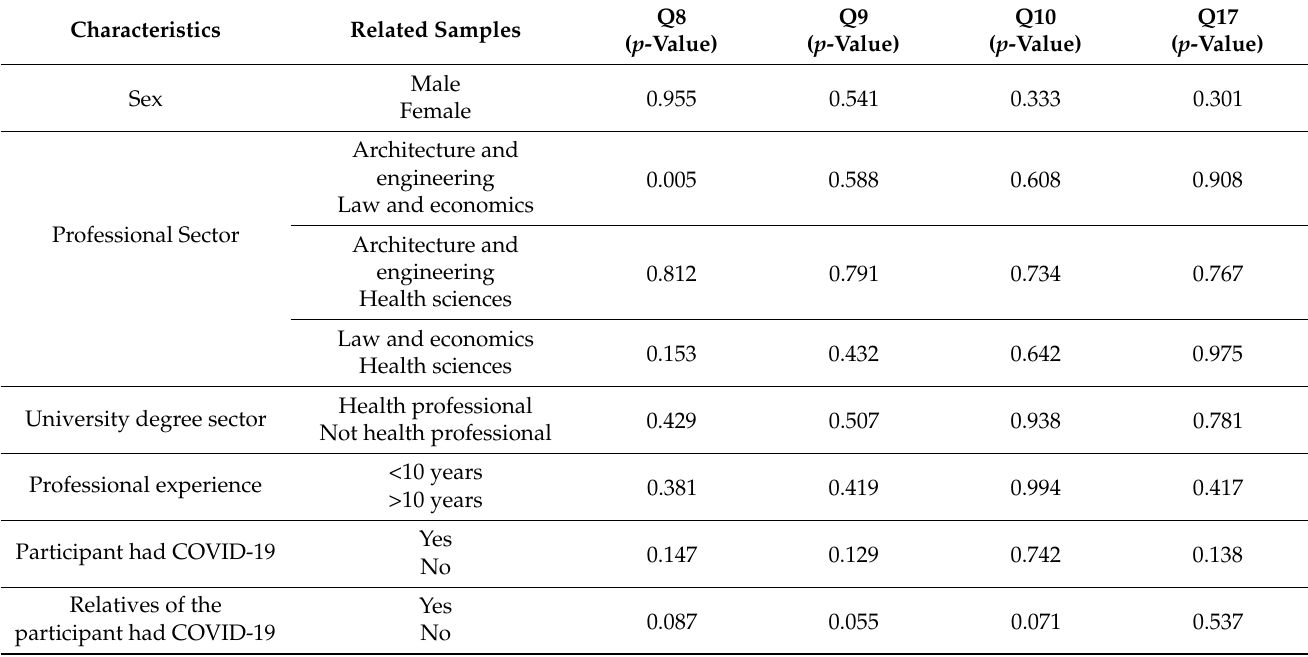
Table 10. Statistical significance analysis on the usefulness of technology and robotics.